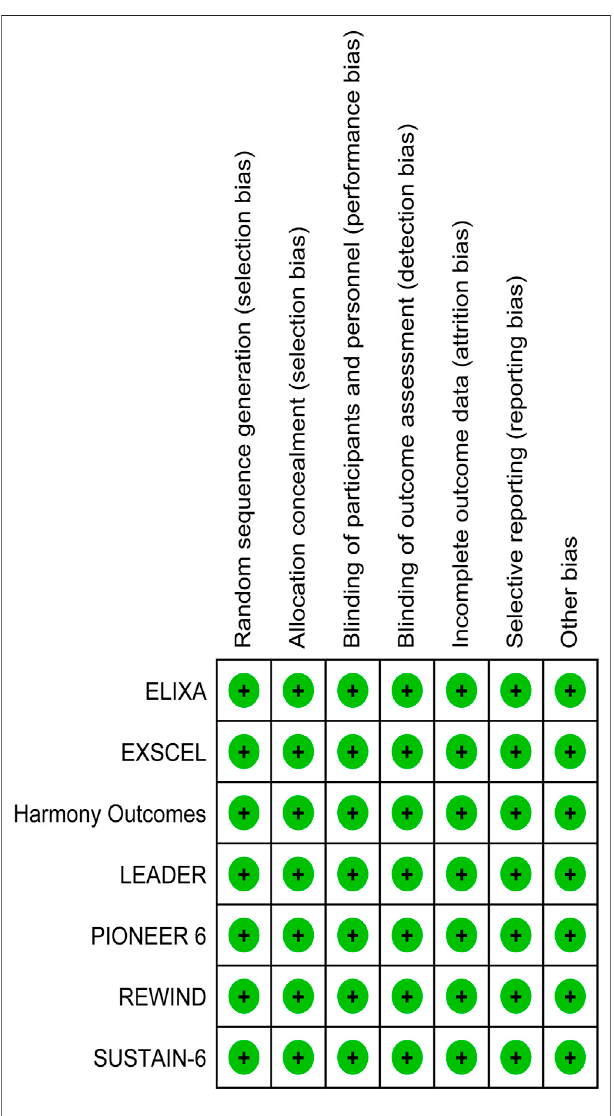
FIGURE 2 | Risk of bias